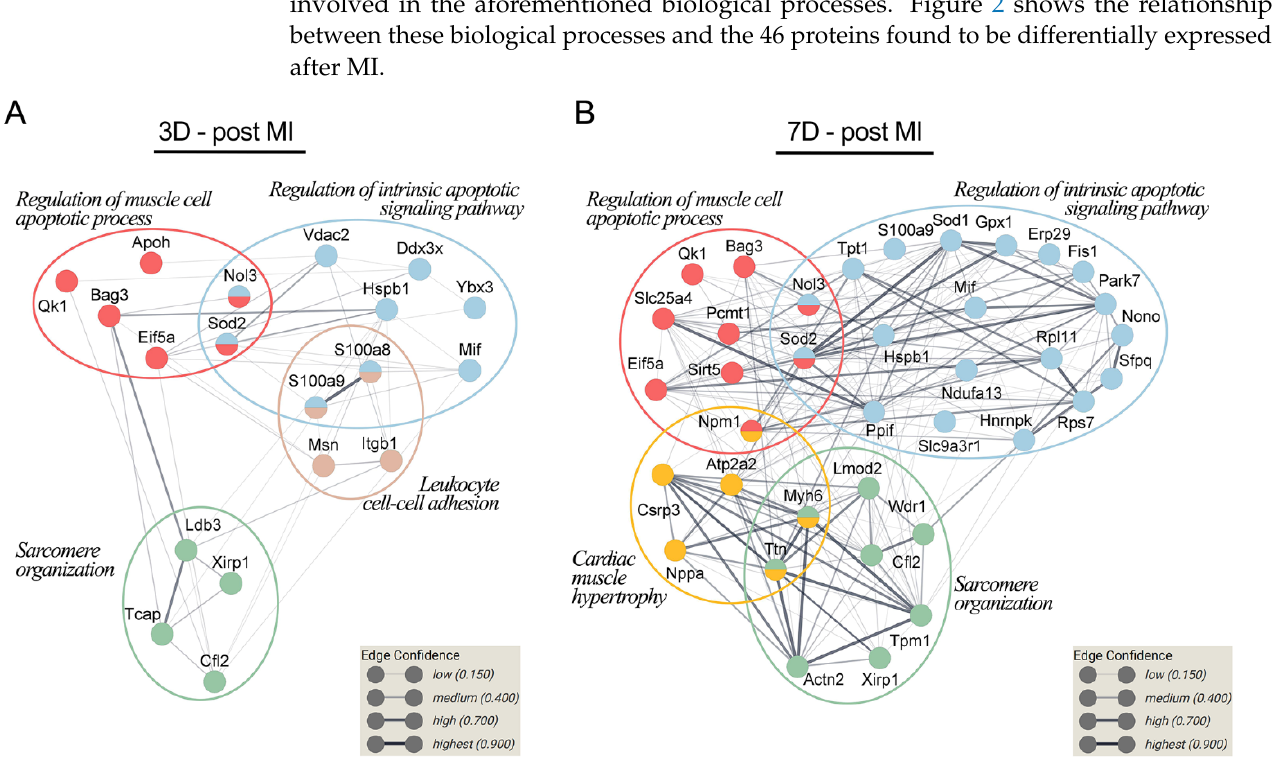
Figure 2. Associations between the biological processes related to ventricle repair and remodeling and differentially expressed proteins (DEPs) between the treatment groups. The protein–protein interaction networks at 3 days ( A ) and 7 days post-MI ( B ) were built using STRING 11.0. The proteins, identified by gene name, are represented as nodes. The thickness of the edge shows the strength of the interaction between two proteins.